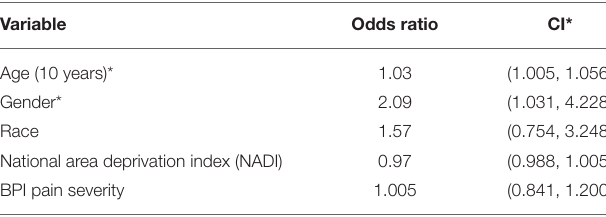
TABLE 3 | Sociodemographic and SES predictors of provider utilization ( n = 174).